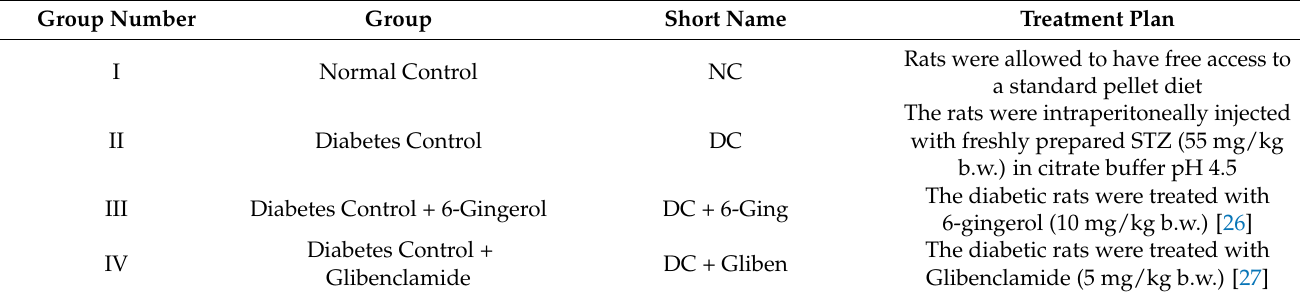
Table 1. A total of 32 male albino Wistar rats were randomly divided into 4 groups